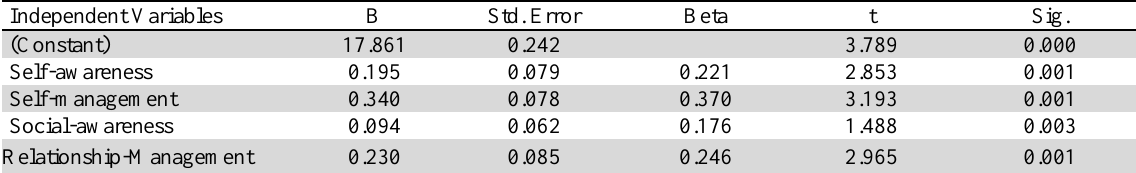
Coefficient equation for multivariable regression Independent Variables